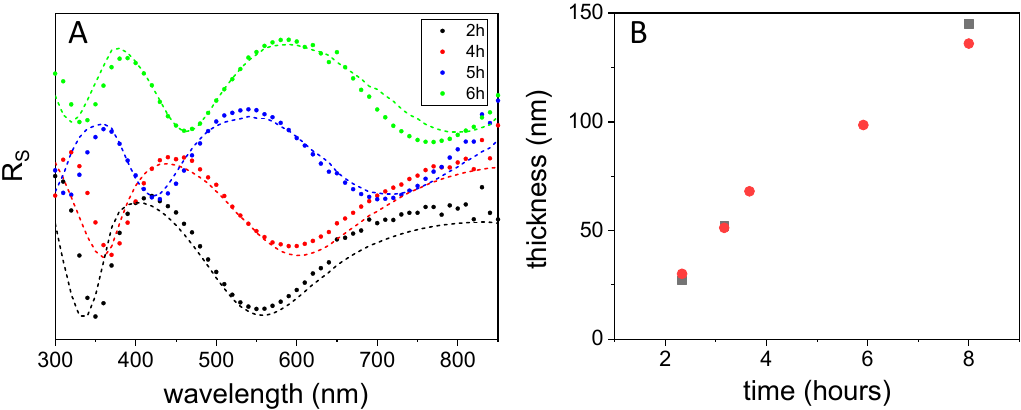
Figure 7. ( A ) Experimental (straight line) and fitted values (dotted) of perpendicular reflectance, R s , for surfaces obtained with different growth time at the incidence angle of 50°. ( B ) Optical ( ● ) vs. AFM ( ■ ) thickness.